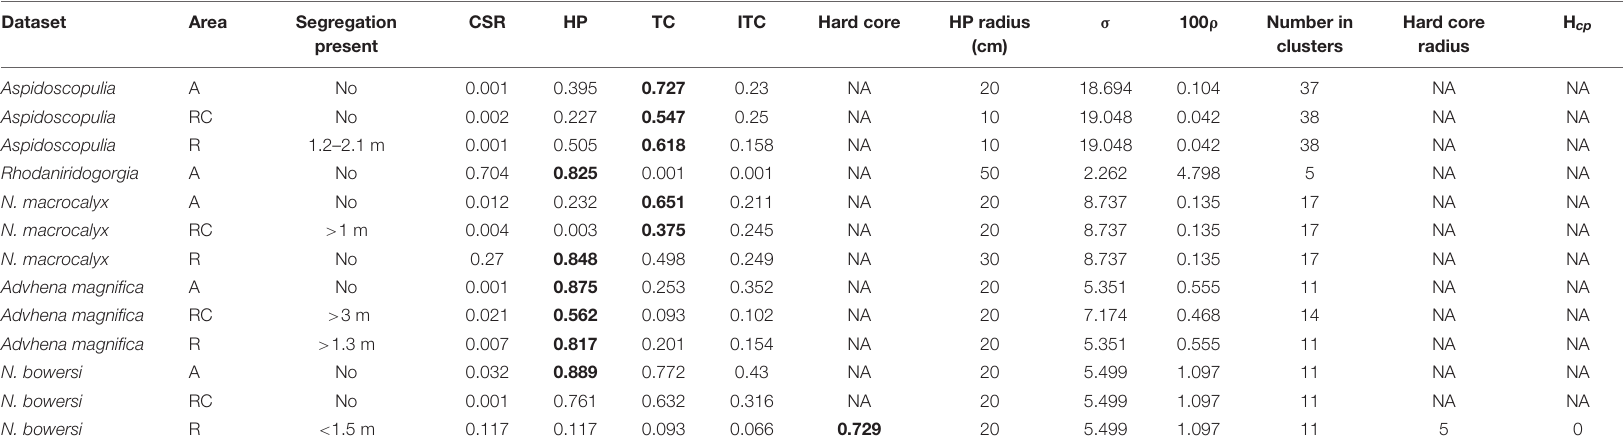
TABLE 4 | Summary table of univariate PCF analyses.